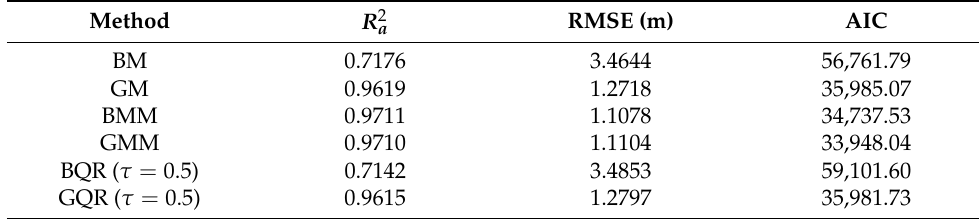
Table 4. Fit statistics for the BM, GM, BMM, GMM, BQR ( τ = 0.5), GQR ( τ = 0.5).